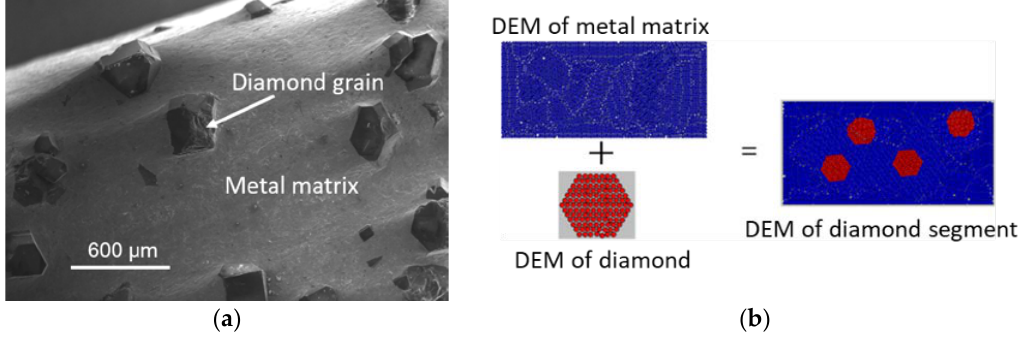
Figure 2. Illustration of establishing the DEM of a diamond segment: ( a ) the morgraphy of diamond segment (observed by Scanning Electron Microscope); ( b ) DEM of a diamond segment.